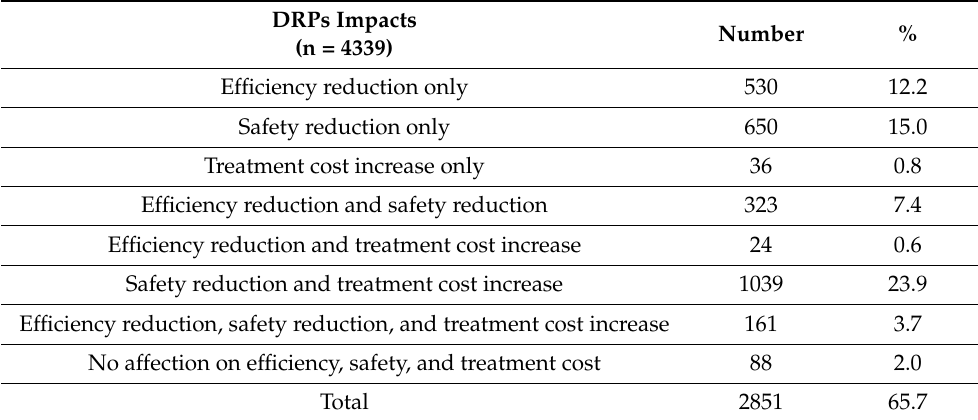
Table A3. Groups of DRPs’ impact on effectiveness, safety, and cost in